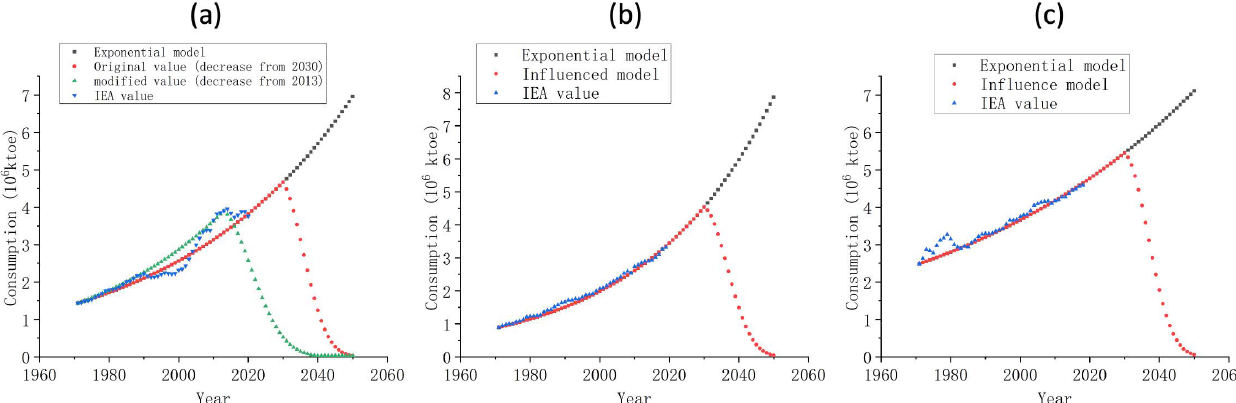
Figure 1. The estimation of the share of fire power generation (2020–2050).